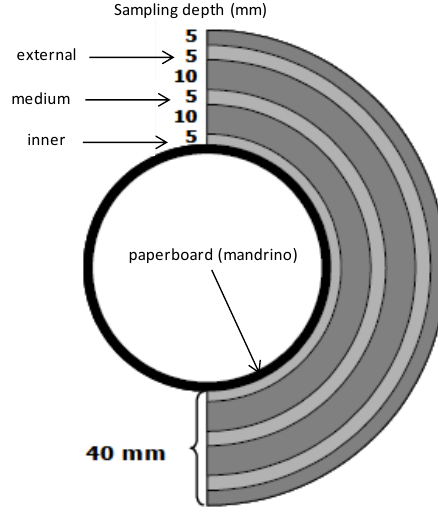
Figure 3. Scheme of sampling of cling-film at different depths of the roll.